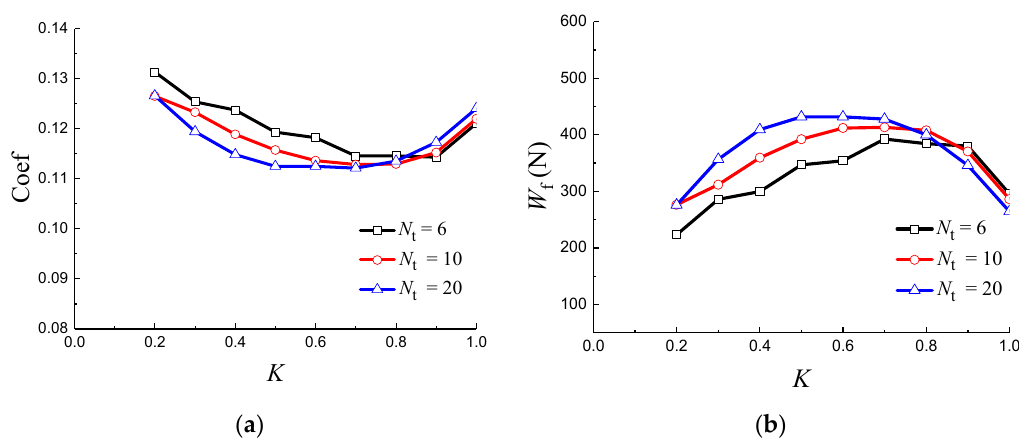
Figure 6. ( a ) Friction coefficient and ( b ) hydrodynamic load-bearing capacity varying with K.